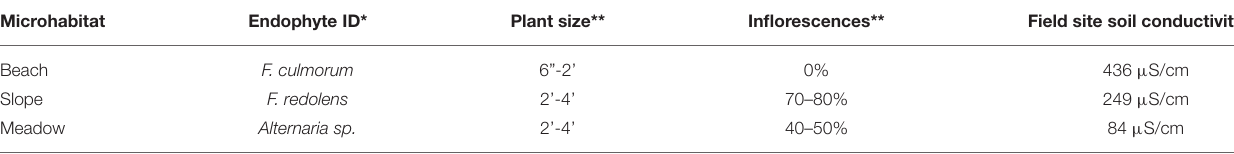
TABLE 3 | Plant metrics and endophyte function across a salt gradient on Cedar Rocks Preserve. Microhabitat